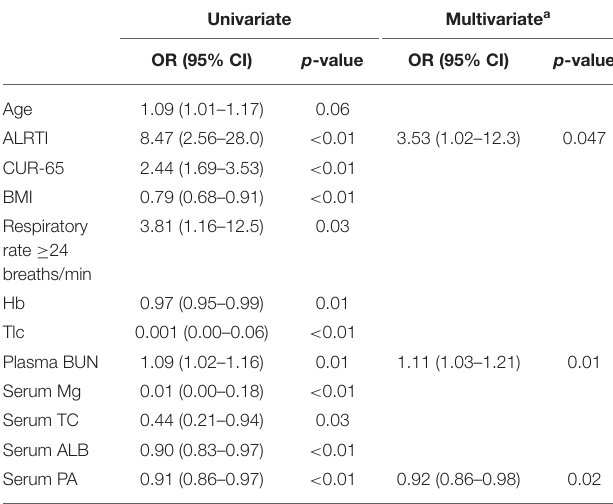
TABLE 4 | Risk factors associated with CVEs in elderly patients with SCAD. Univariate Multivariate a